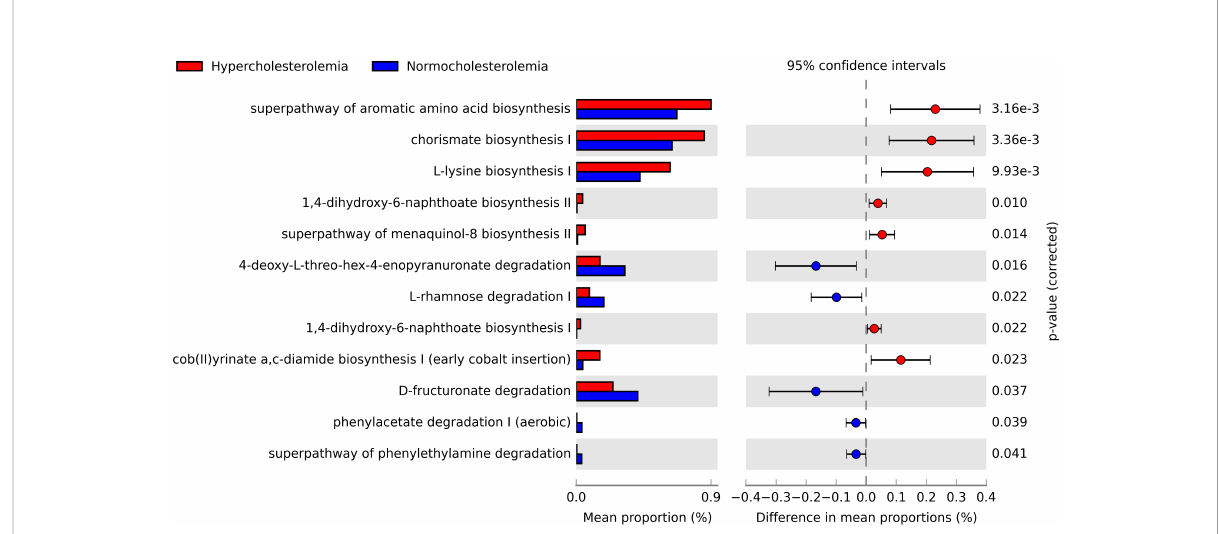
FIGURE 4 Pathways obtained through PICRUSt2, which are signi fi cantly associated with hypercholesterolemic individuals and controls. The presence of biosynthetic pathways predominates in hypercholesterolemic individuals, while degradation pathways are more relevant in controls. P-value